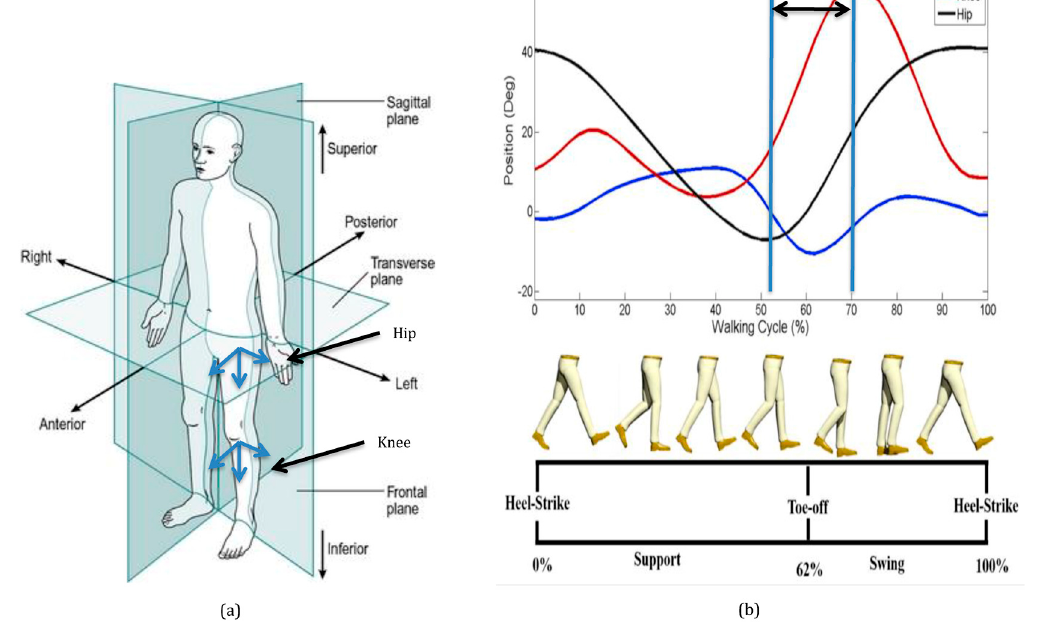
Figure 2. One gait cycle of human walking: ( a ) description of the hip and knee local coordinate system that are referenced to the anatomical position in three reference planes; ( b ) description of the phase difference motion of the hip and knee in the sagittal plane [17].